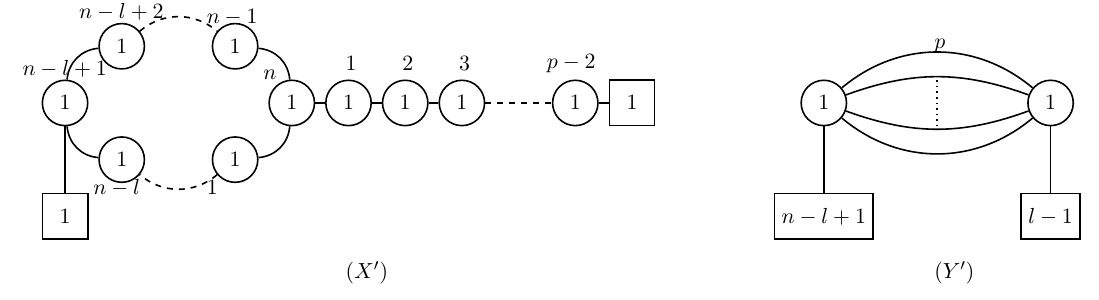
Figure 17 . A three-parameter family of dual quiver gauge theory pairs with U(1) gauge groups labelled by the integers ( n, l, p ) with n > l − 1 > 0 , and p ≥ 2 . Their construction from linear quivers by identification-gauging operations is shown in figure 19.